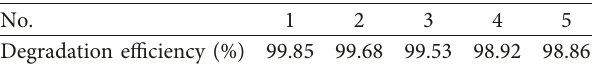
Figure S1: the calibration graph of MB solution at λ about 644 nm. Table S1: the effect of time on adsorption percentage of M2 for MB. Table S2: the effect of MB con- centration solution on the adsorption capacity. Table S3: the effect of hydrogen peroxide concentration on the degra- dation percentage of MB. Table S4: the effect of time on the degradation percentage of MB. Table S5: the effect of pH on the degradation percentage of MB. Table S6: the effect of the amount of the M2 on the degradation percentage of MB.